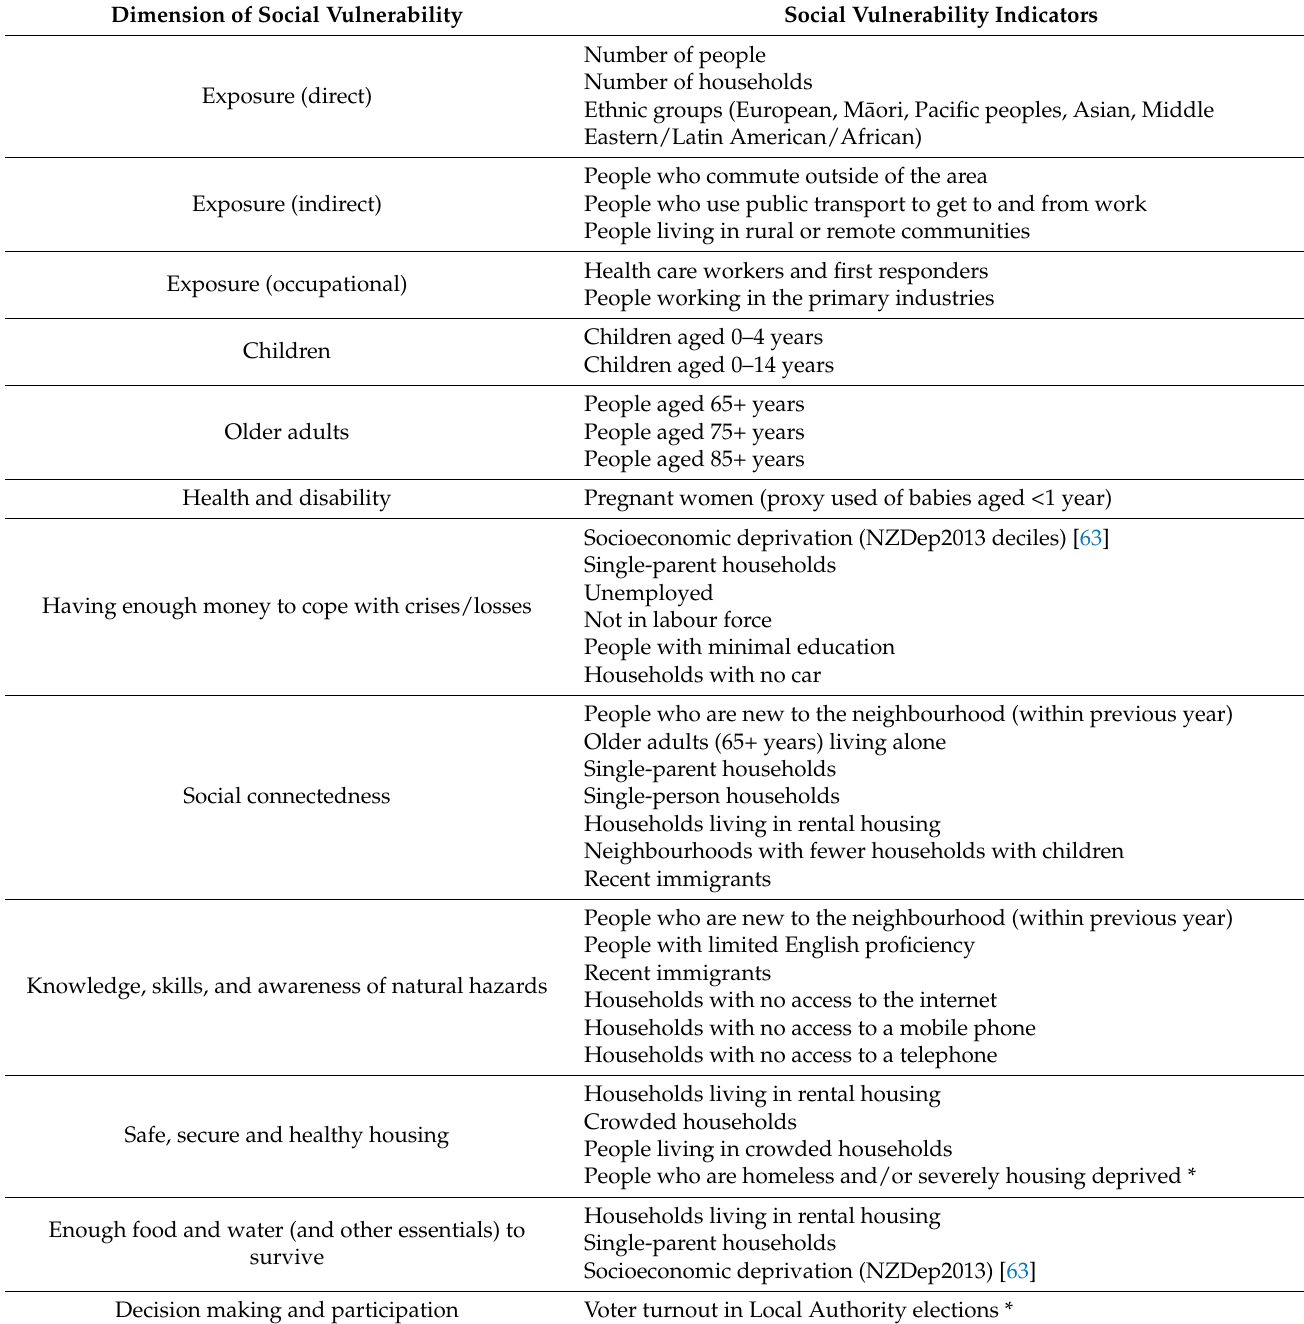
Table 3. Social vulnerability dimensions and indicators for flooding for New